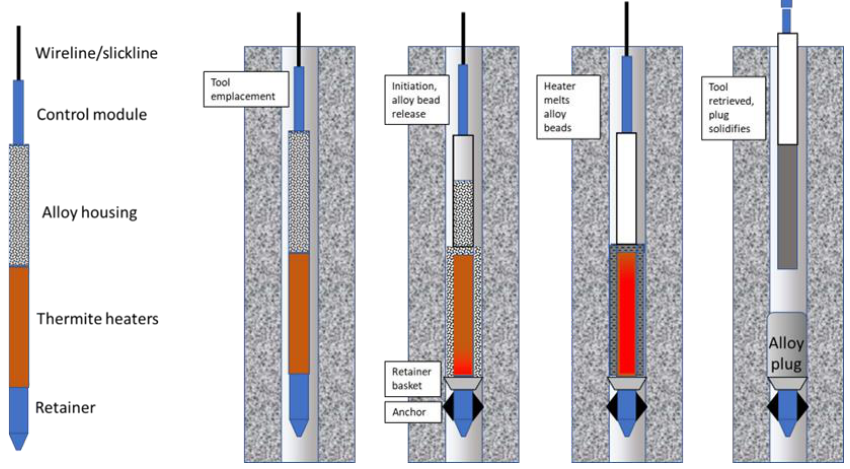
Figure 3. Fusible metal alloy emplacement, where thermite acts only as a removable heater. Thermites are a class of energetic material which combines a combustible metal with an oxide to release large amounts of thermal energy (Figure 4) [17]. A common formulation is the aluminum/ferric oxide system, where aluminum is the combustible metal and